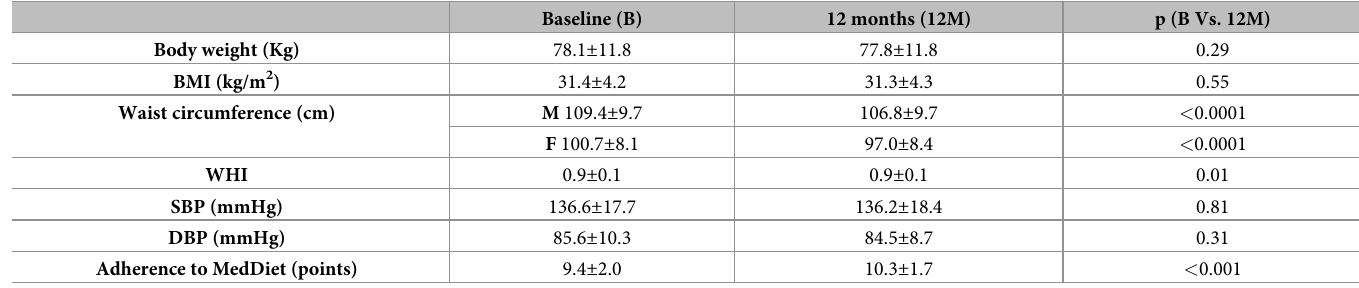
Table 1. Anthropometric parameters and MedDiet adherence at baseline and after 12 months of intervention (Mean ±